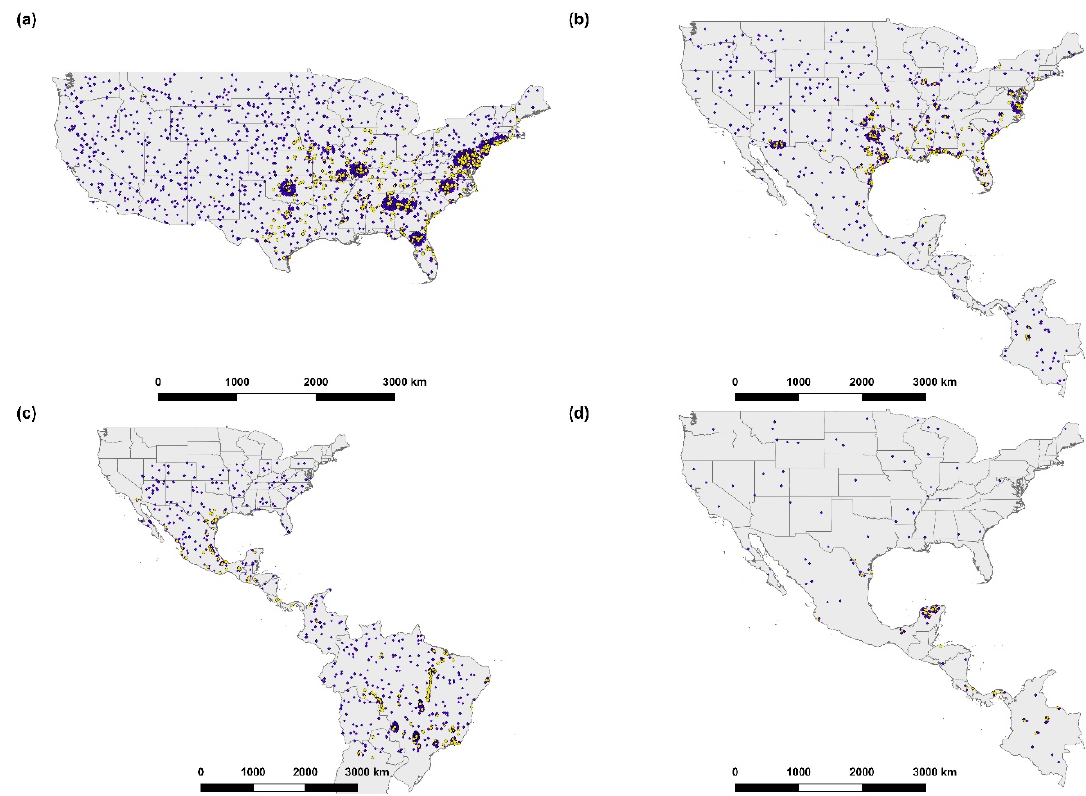
Figure 2. Geolocations used in MaxEnt modeling to predict suitable habitat in California for four Amblyomma tick species: ( a ) A. americanum, ( b ) A. maculatum , ( c ) A. cajennense, and ( d ) A. mixtum . Presence geolocations (yellow circles) were obtained from the published literature and open access databases, and background geolocations (blue squares) were simulated according to assumed presence sampling bias.